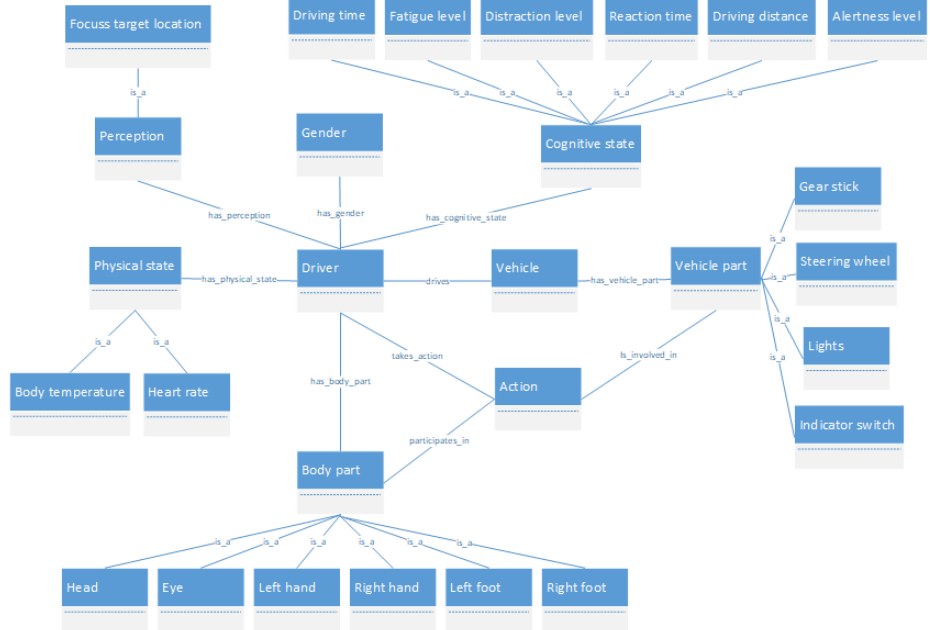
Figure 2. Part of the driver behavior ontology with a selection of the main classes and relations defined for modeling the driver